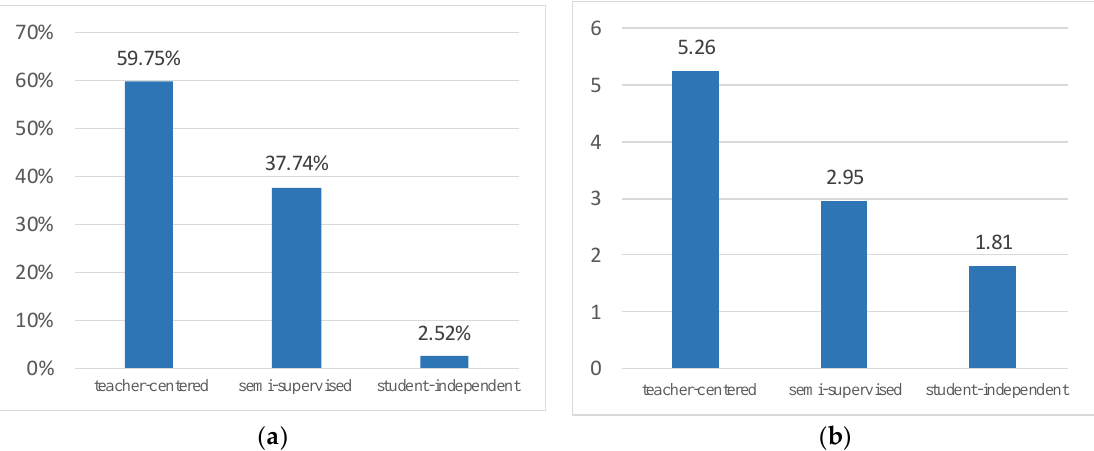
Figure 8. ( a ) The result in which one of the three applied modes based on the fieldwork platform is preferred. ( b ) The result in allocating the three applied modes to the 10-day